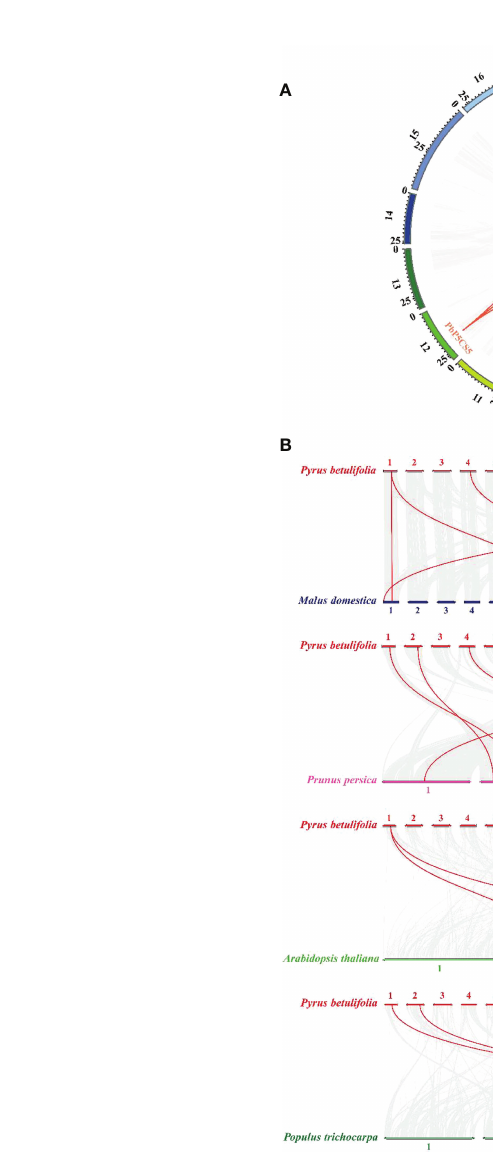
FIGURE 4 Synteny analysis of P5CS genes. (A) Synteny analysis of PbP5CS genes in pear. Gray lines indicate collinear blocks in the whole Pyrus betulifolia genome, and red lines indicate duplicated PbP5CS gene pairs. (B) Synteny analysis of P5CS genes in the P. betulifolia , Populus trichocarpa , Arabidopsis thaliana , Malus domestica , and Prunus persica genomes. Red lines highlight syntenic P5CS gene